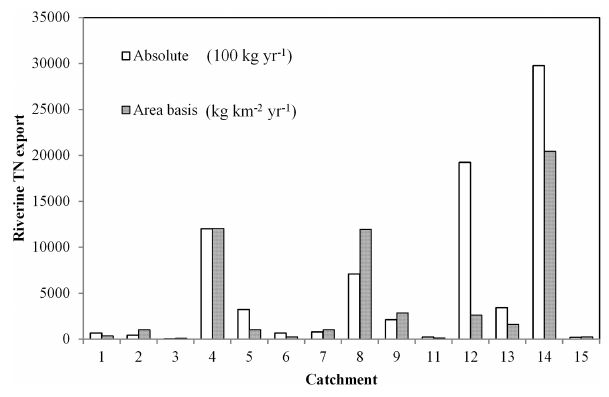
Figure 4. Riverine N export from 15 catchments in the Lake Di- anchi basin. Catchments 4, 12, and 14 comprised 76.2% of the total riverine N input, and catchment 14 is the highest both on the basis of absolute flux or flux per area, while catchment 12 ranks differently when expressed per area of watershed. Catchment 10 is omitted here because there are no monitoring stations